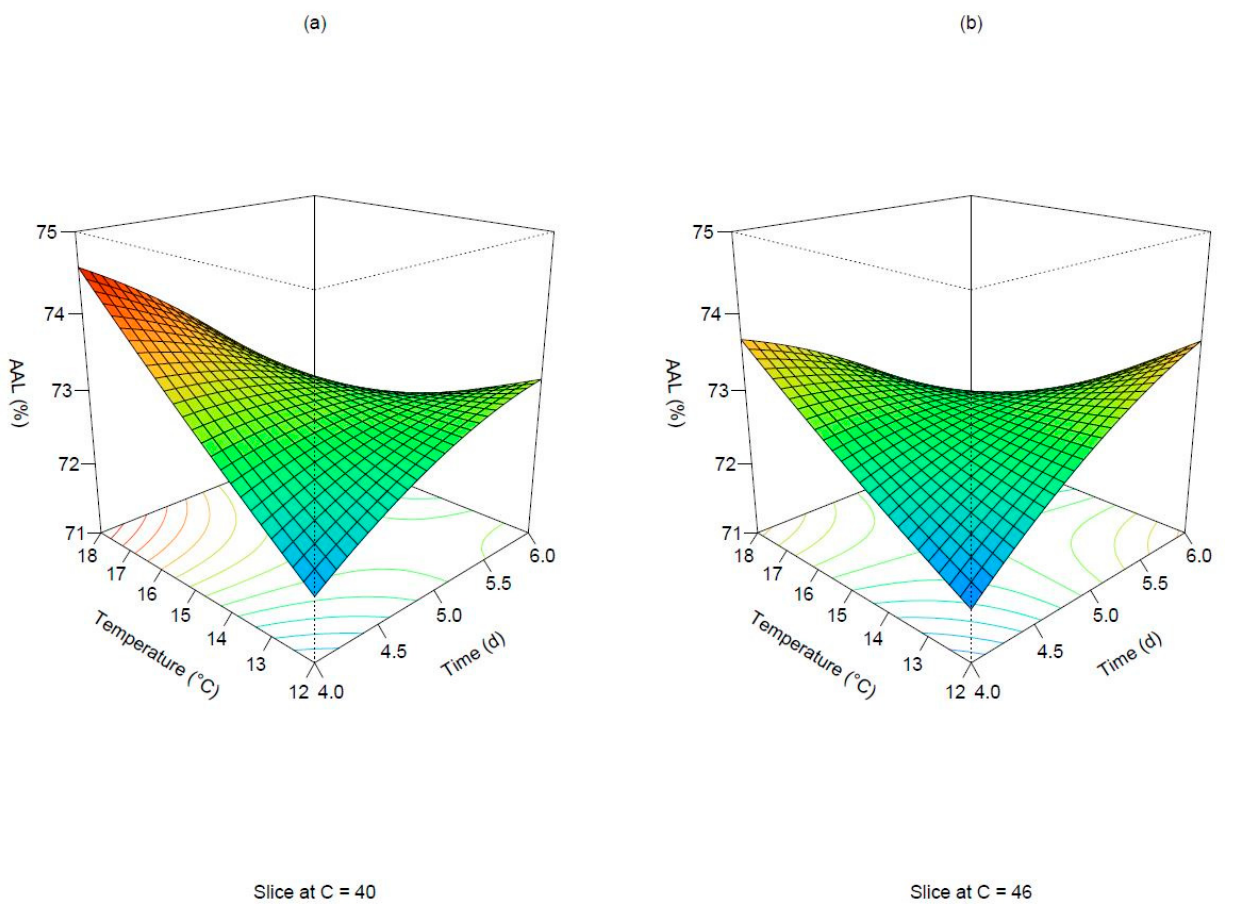
Figure 4. Surface plots of the predicted apparent attenuation limit. The degree of steeping is held at 40 g/100 g ( a ) and 46 g/100 g ( b